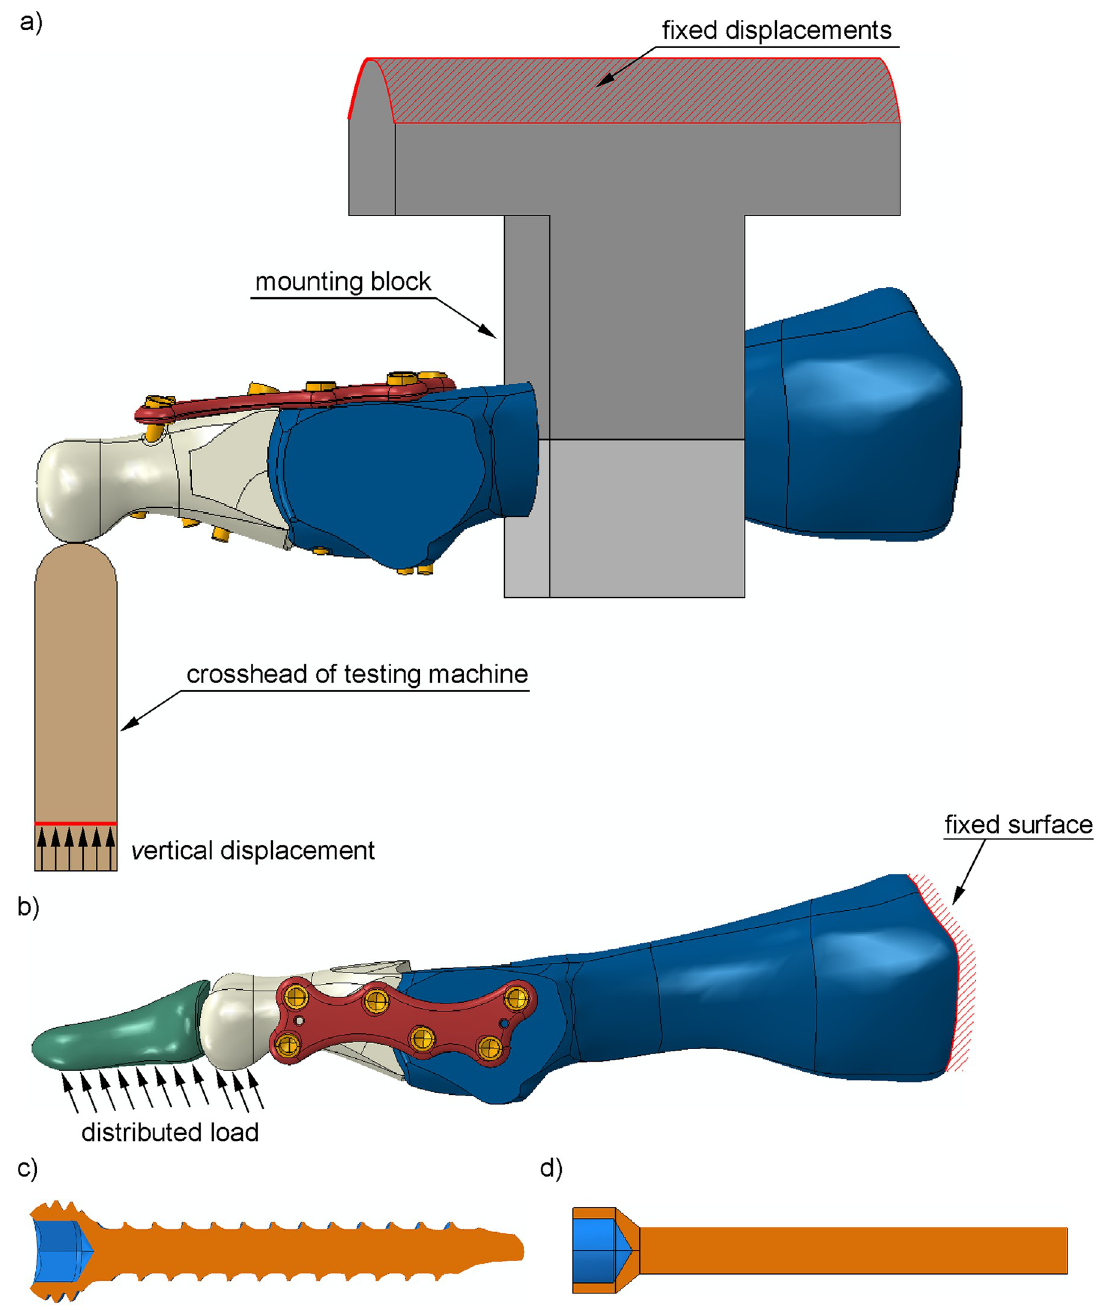
Fig 4. Geometry of the numerical models and boundary conditions used in a) simulation of the experiment for the dorsal plate and b) simulation of the toe-off phase of gait for the medial plate. Cross section through c) the original screw and d) simplified screw used in the